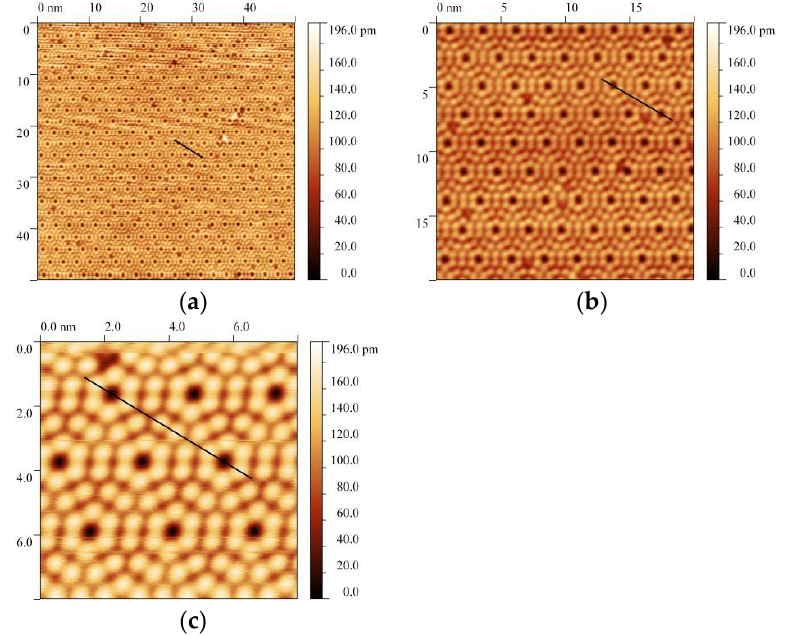
Figure 1. Comparison of the image contrast with an increase in the scan area on a clean Si(111)-7 × 7 surface: ( a ) 50 × 50 nm; ( b ) 20 × 20 nm; ( c ) 8 × 8 nm.